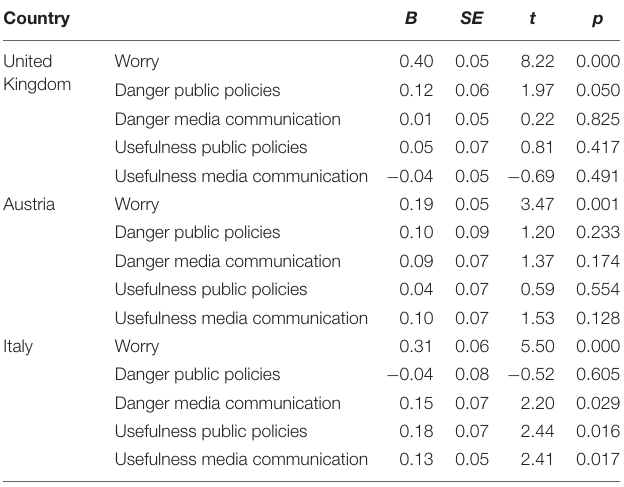
TABLE 4 | Regression analysis for perceived threat. Country